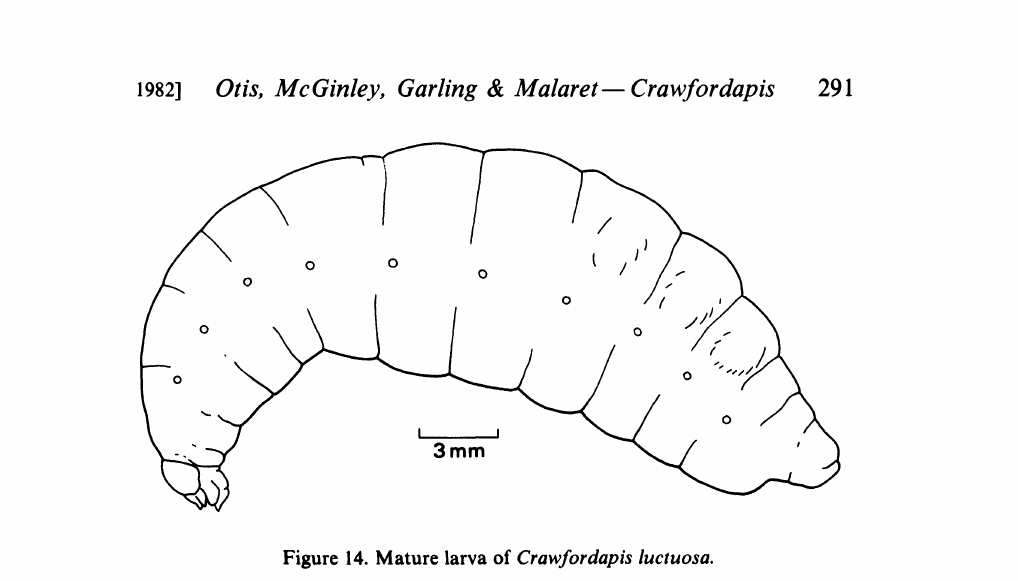
Figure 14. Mature larva of Crawfordapis